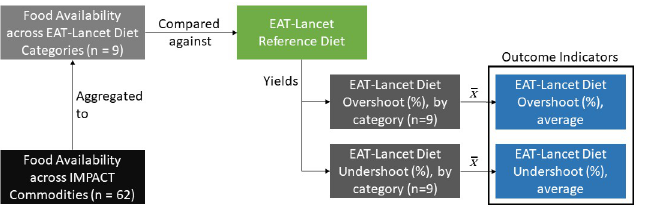
Fig 1. Aggregation and computation method for dietary quality metrics—Overshoot of EAT-lancet dietary guidelines and undershoot of EAT-lancet dietary guidelines.